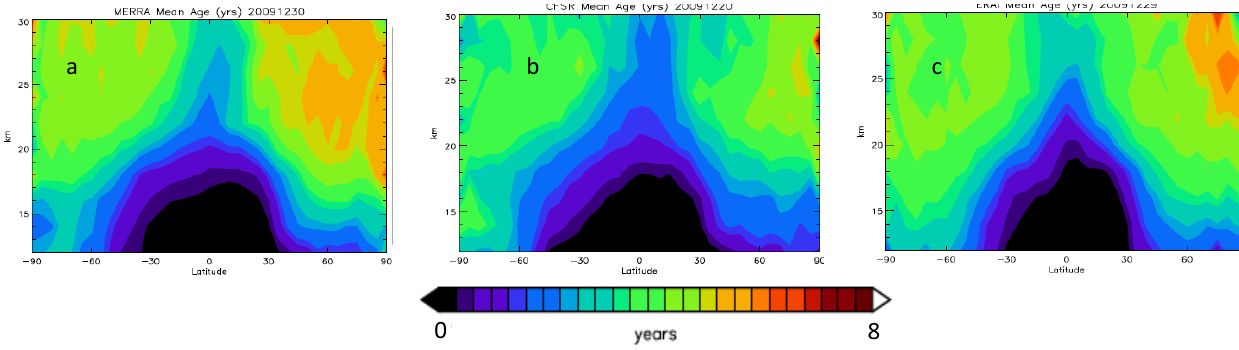
Fig. 2. Mean ages (years) for MERRA (a) , CFSR (b) , ERAi (c) computed in December 2009 after 30yr